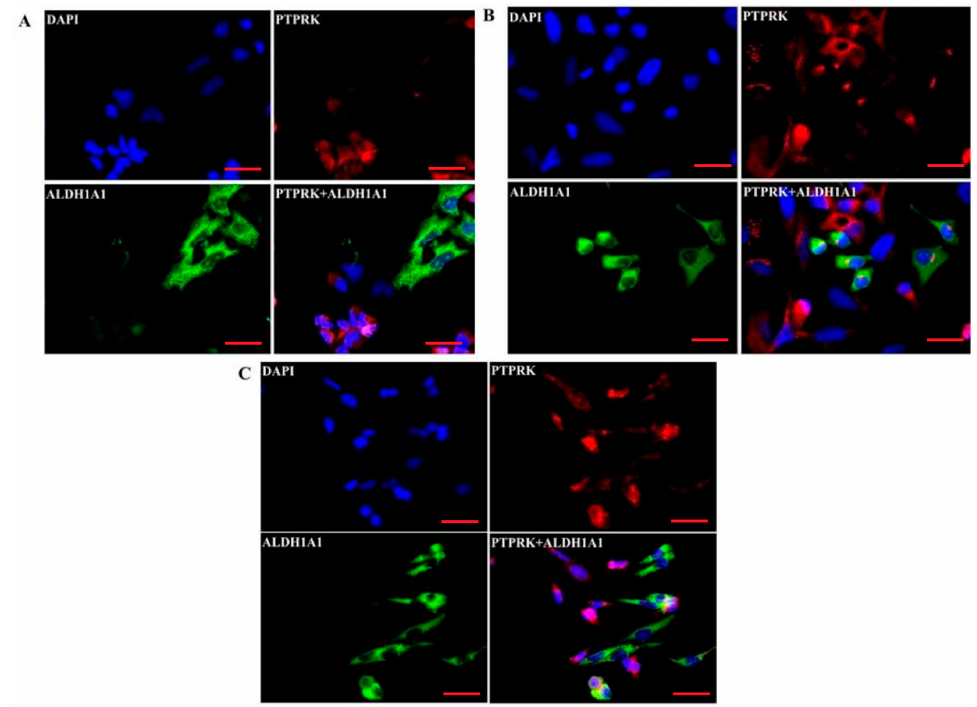
Figure 5. Immunofluorescence visualization of PTPRK and ALDH1A1 co-expression in the W1TR ( A ), W1PR2 ( B ) and A2780PR1 ( C ) cell lines. PTPRK was detected using the anti-PTPRK antibody and Alexa Fluor ® 594 secondary antibody (red). ALDH1A1 was detected using the anti-ALDH1A1 antibody and Alexa Fluor ® 488 secondary antibody (green). To visualize the cell nuclei, the cells were mounted with a DAPI-containing mounting medium (blue). Scale bar = 20 µm.